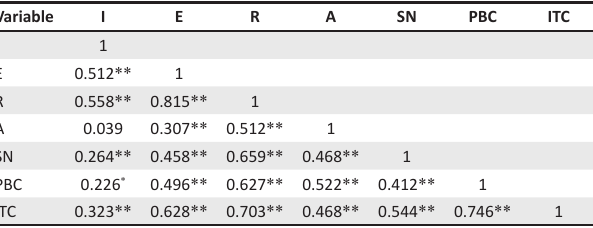
TABLE 1: Matrix of correlation coefficients among study constructs. Variable